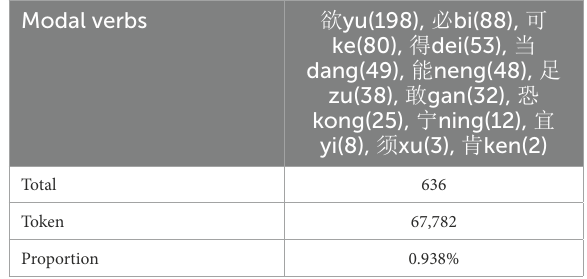
TABLE 4 Common modal verbs in the three translations. Modal